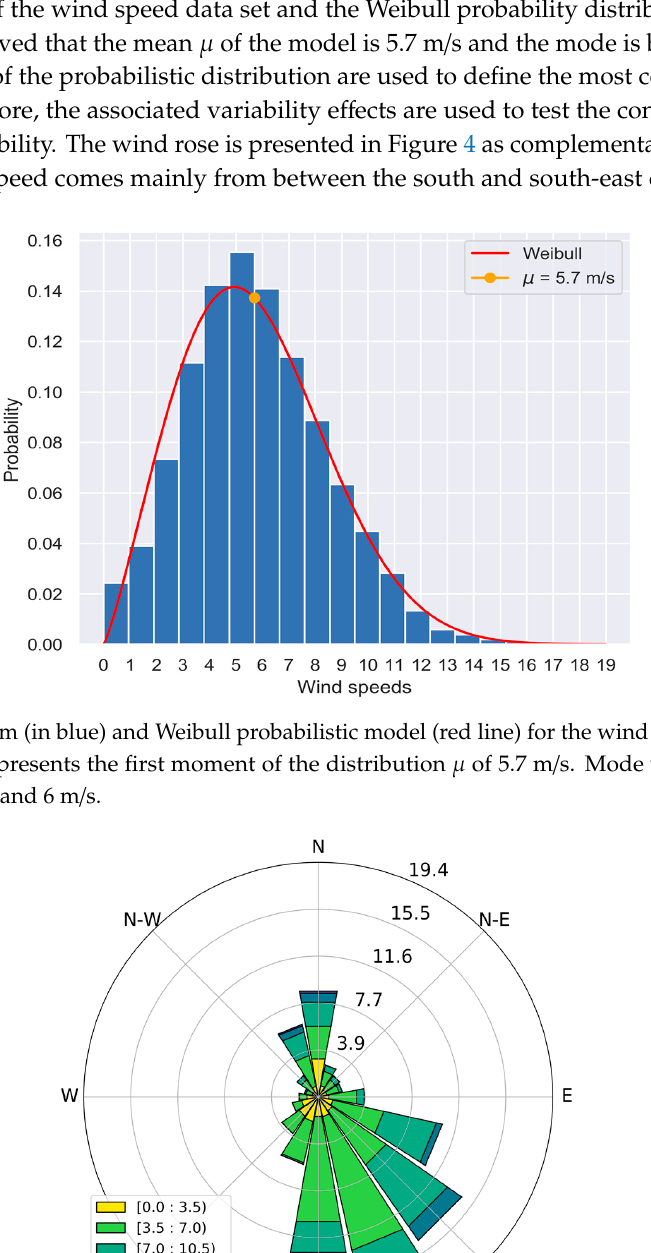
Figure 2. Location of the anemometric mast installed in the municipality of Soto la Marina in the state of Tamaulipas, Mexico.